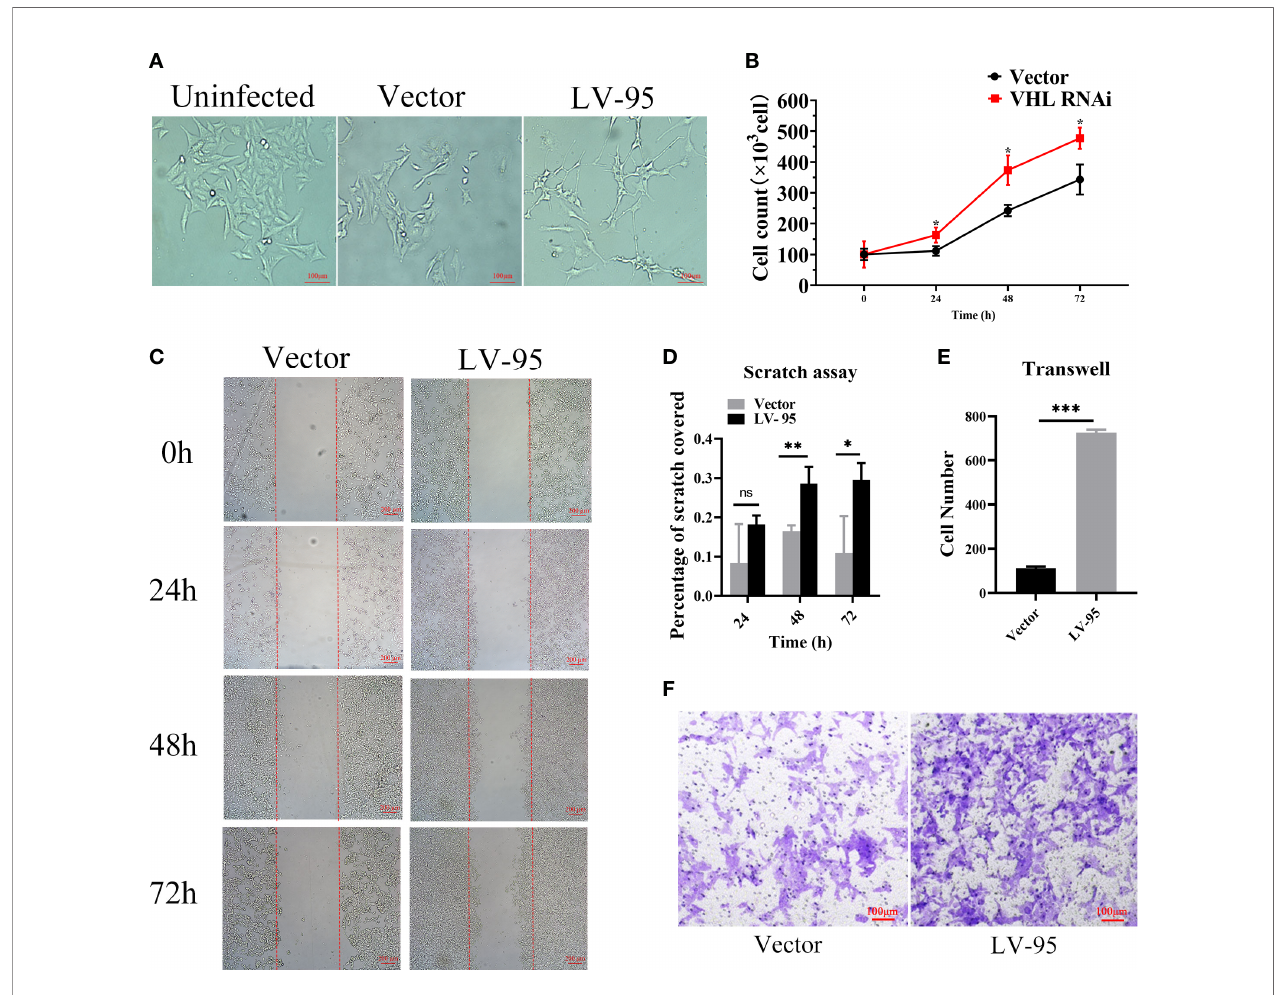
FIGURE 6 | VHL-KD changed the cell morphology and promoted the proliferation and migration of PC12 cells. (A) Phase contrasted 10× images of VHL-KD (LV-95) and empty vector-transfected (Vector) PC12 cells. (B) Growth chart of VHL-KD and VHL empty vector-transfected cells, *P < 0.05. (C, D) Phase-contrast micrographs illustrating migration by wound healing of PC12 cells transduced with empty vector or VHL shRNA. Images were taken at different time points after wounding, as indicated. n = 3, ns: non signi fi cant, * P < 0.05, ** P < 0.01. (E, F) Down: Micrographs illustrating trans-migration of PC12 cells transduced with empty vector or VHL shRNA. Up: Bar graphs indicated trans-migration relative to empty vector transduced cells. *** P <